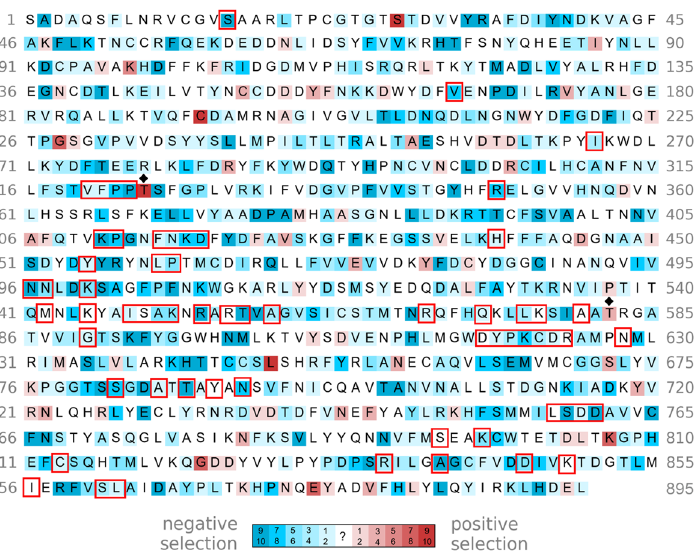
Figure 6. Selection pressure of SARS-CoV-2 RdRp residues. The sequence after L895 in the cryo-EM structure (PDB 7aap) has deletions or missing residues, and could not be reliably mapped to the aa residues from the gene sequences. RdRp residues under increasing negative and positive selection are depicted by increasing blue and red intensity, respectively, whereas those with no evidence to support negative or positive selection are in white. All drug-interacting residues are boxed and those neighboring residues under positive selection are indicated by black